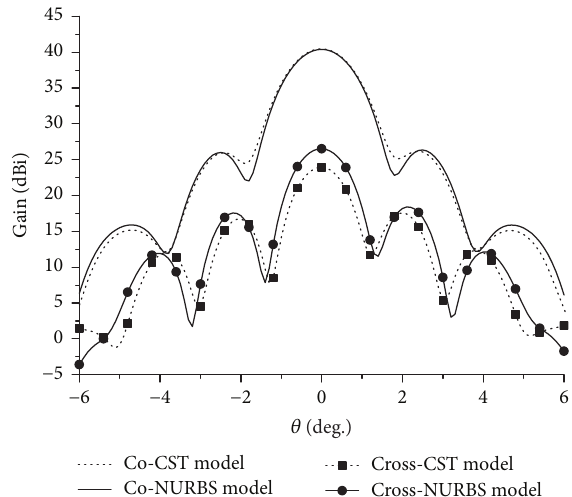
Figure 6: Simulating radiation pattern of antennas A and B in 𝜑 = 90 ∘ plane.